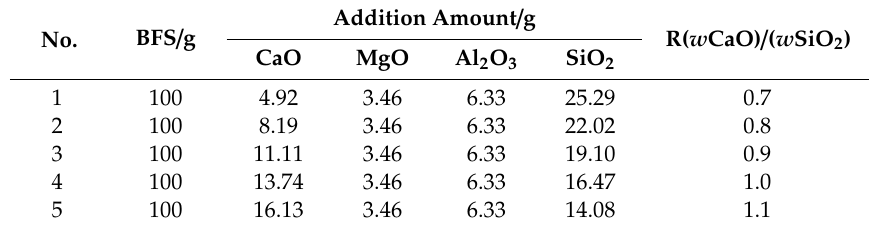
Table 2. Components of BFS for